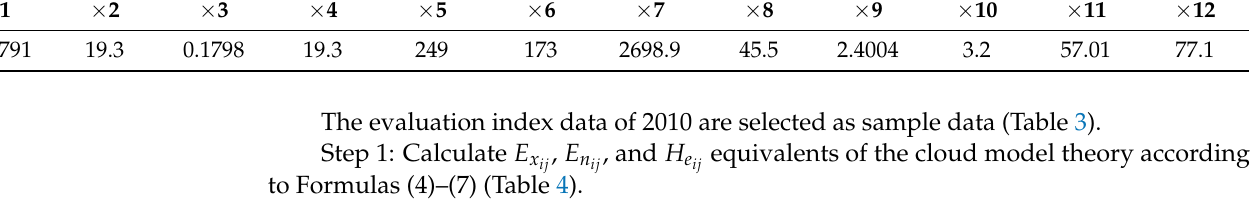
Table 4. Classification of index